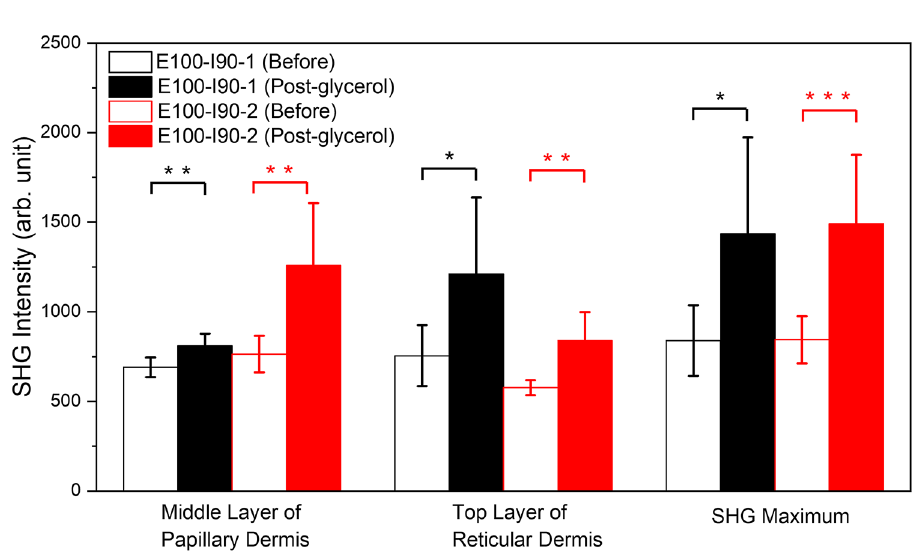
Figure 5. Quantitative analysis and comparison of skin SHG intensities at three different depths. Black: Case E100-I90-1 (Before: N = 8, Post-glycerol: N = 8); Red: Case E100-I90-2 (Before: N = 9, Post-glycerol: N = 9). * P < 0.05; ** P < 0.01; *** P < 0.001. Before: before treatment; Post-glycerol: after